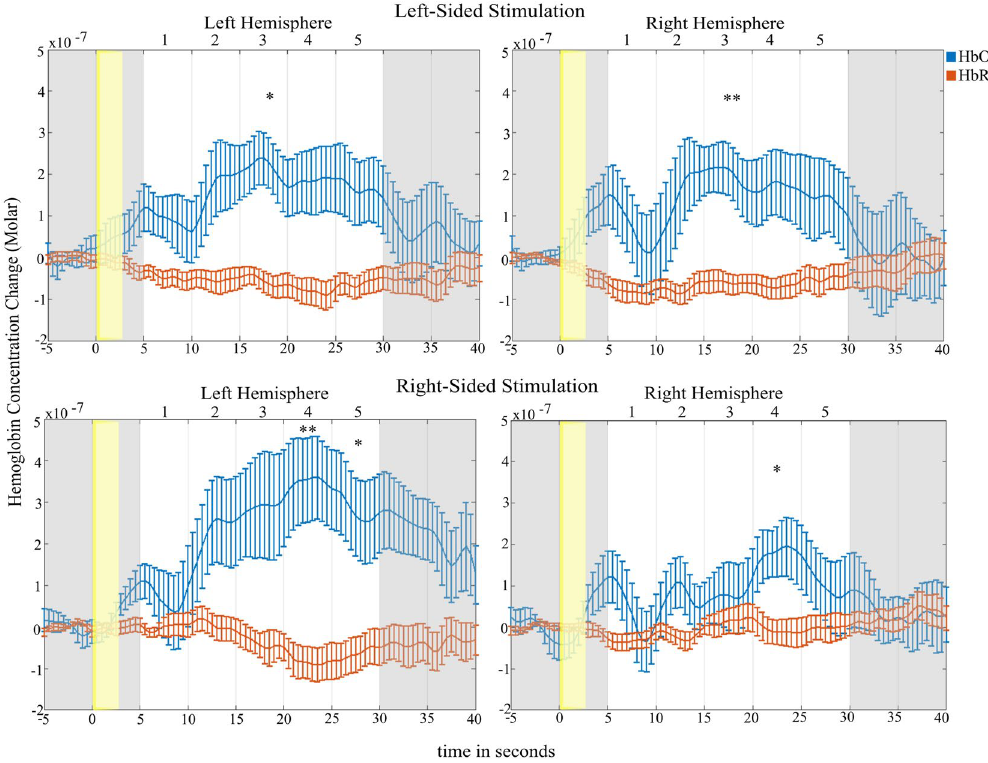
Figure 5. Grand average hemodynamic responses of left-sided stimulation (top) and right-sided stimulation (bottom) for the left and right hemispheres. Number 1–5 in the upper part of each subfigure denote the analyzed temporal windows. Error bars correspond to + / − SEM. * p = 0.01, ** p < 0.01; HbO vs baseline.